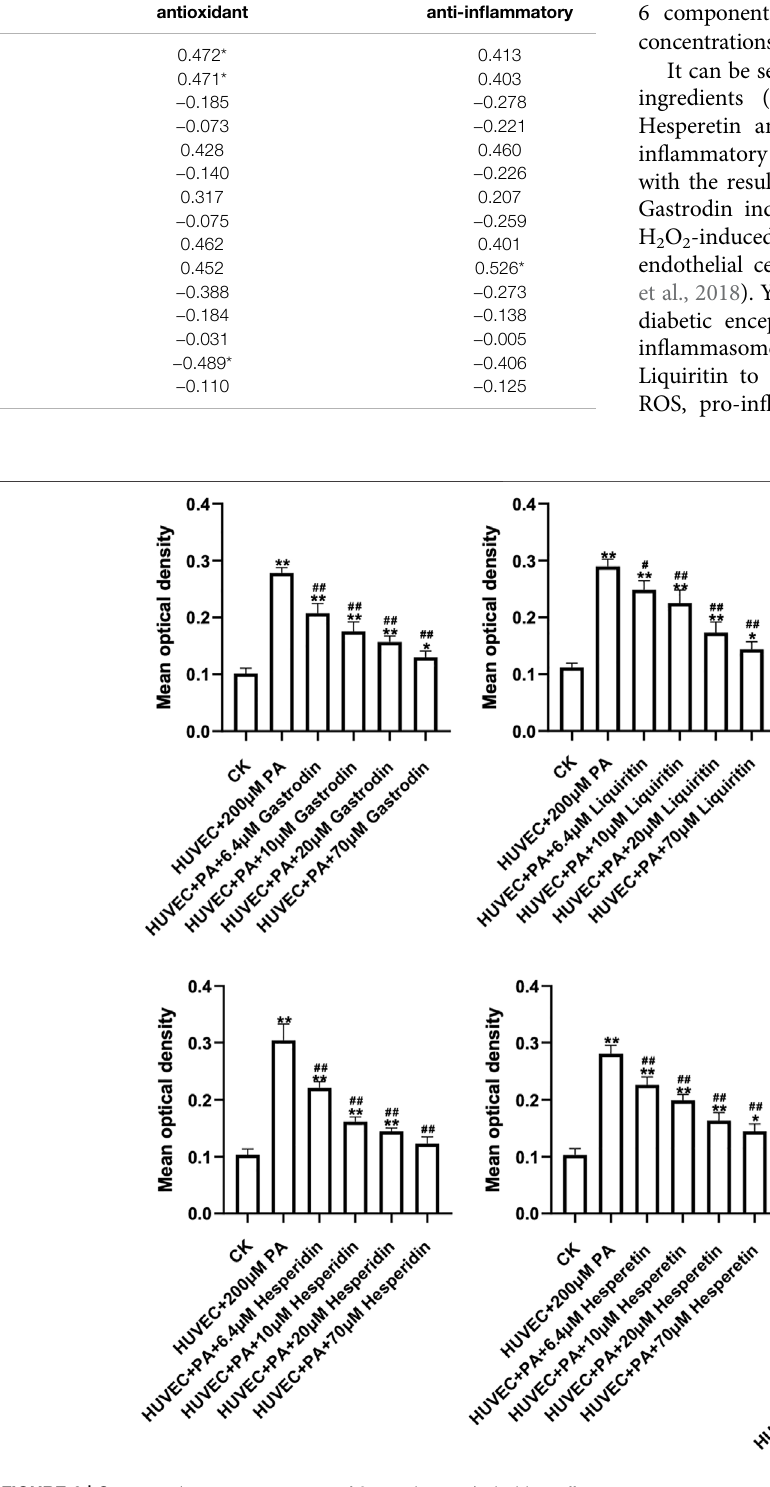
FIGURE 6 | Concentration-response curves of 6 constituents Antioxidant